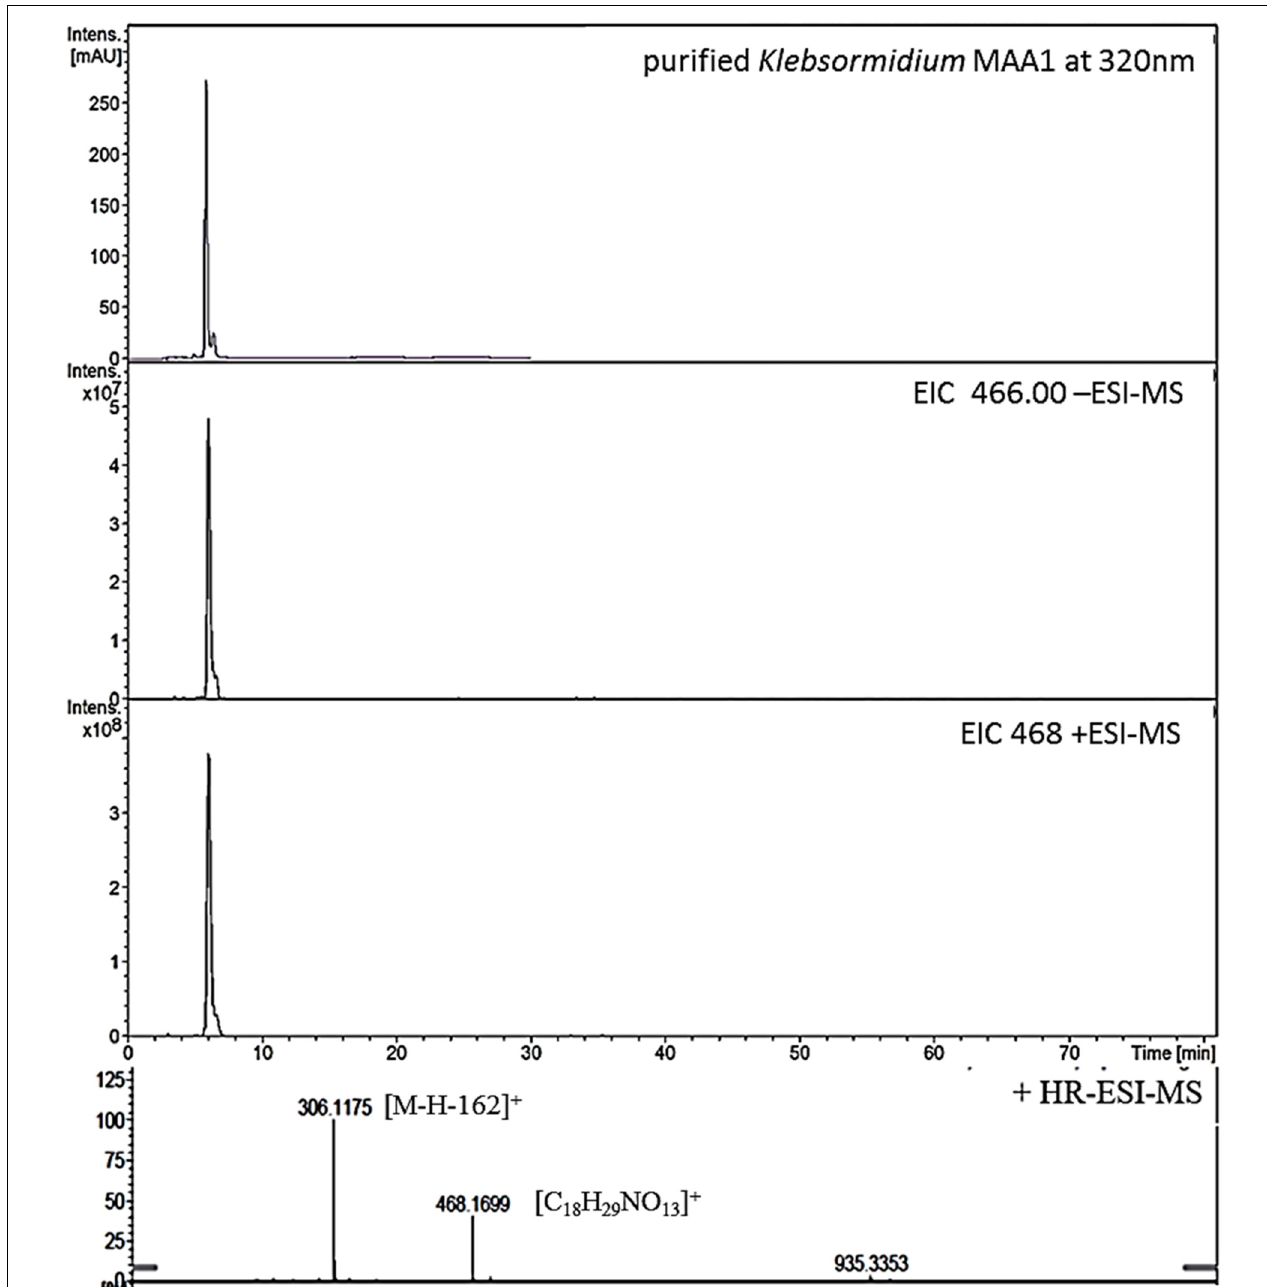
FIGURE 1 | High resolution – electrospray ionization – mass spectrometry (HR-ESI-MS) spectra recorded for Compound 1 (klebsormidin A) isolated from extracts of Klebsormidium crenulatum .